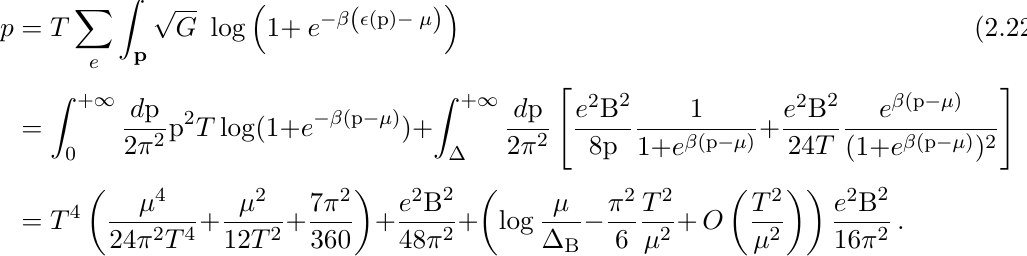
Figure 1 . In the low temperature limit T Fermi sphere. When considering the interaction with Berry monopole located at the origin, the states within the inner sphere with radius mechanical effects are dominant. The outer sphere shows the Fermi surface in the limit µ While the kinetic theory works for . µ ∆ B . p | |